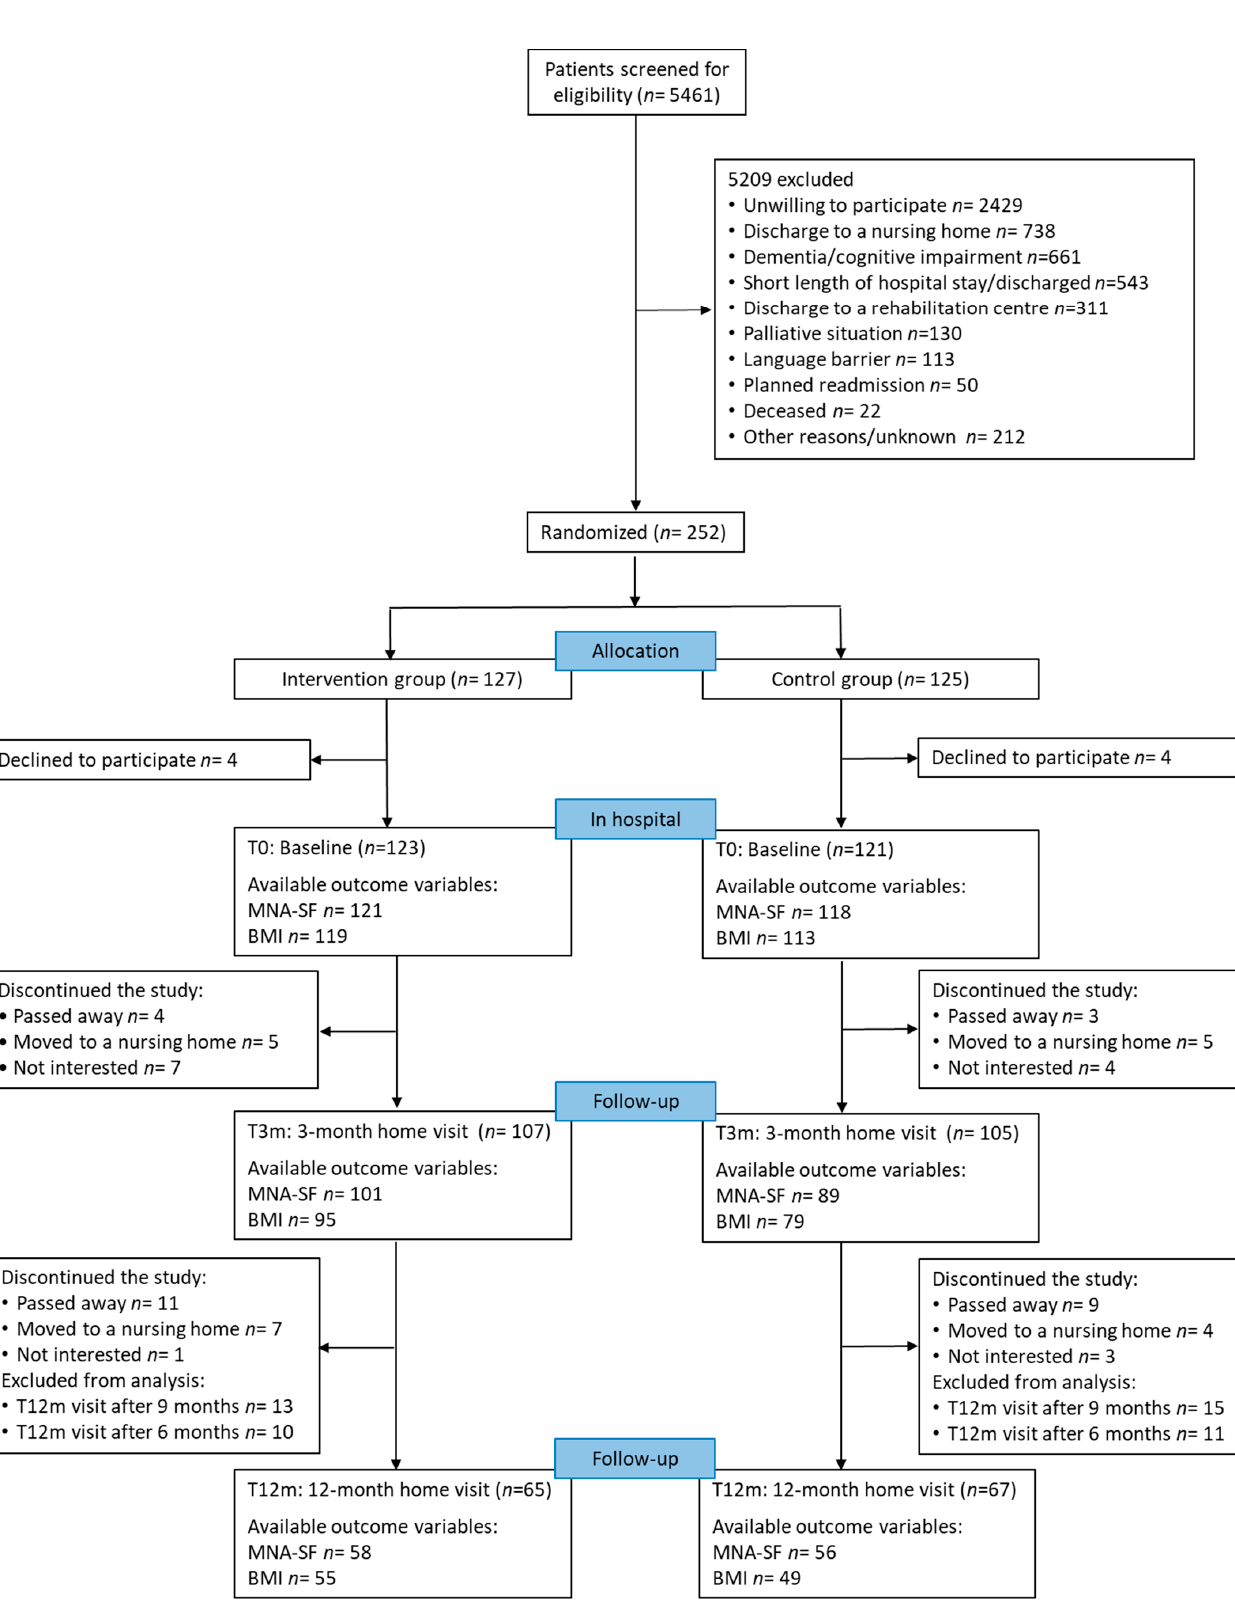
Figure 1. Flow of patient participation during the study, available outcome variables and reasons for dropout and exclusion from analysis; MNA-SF: Mini Nutritional Assessment-Short Form; BMI: Body Mass Index.